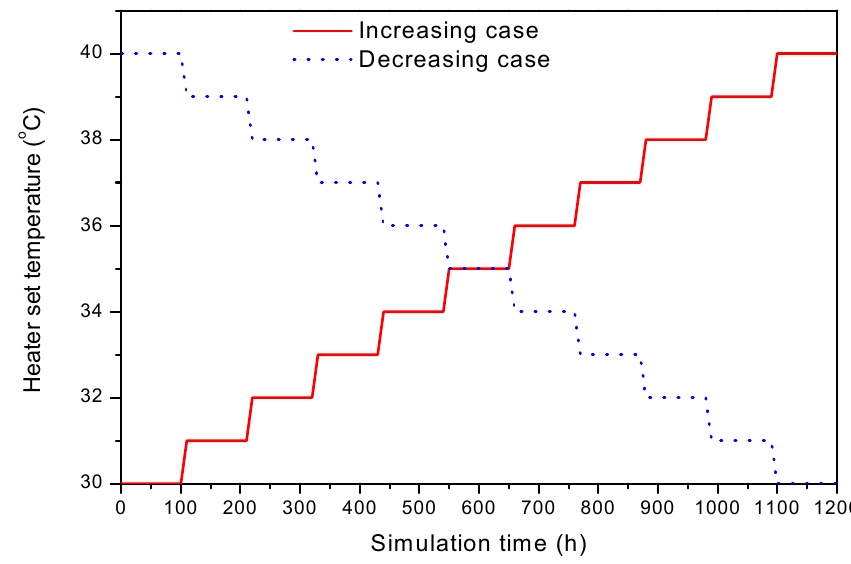
Figure 5. Variation in the heater set temperature with respect to the simulation time. Table 2. Operating conditions for each calculation case.